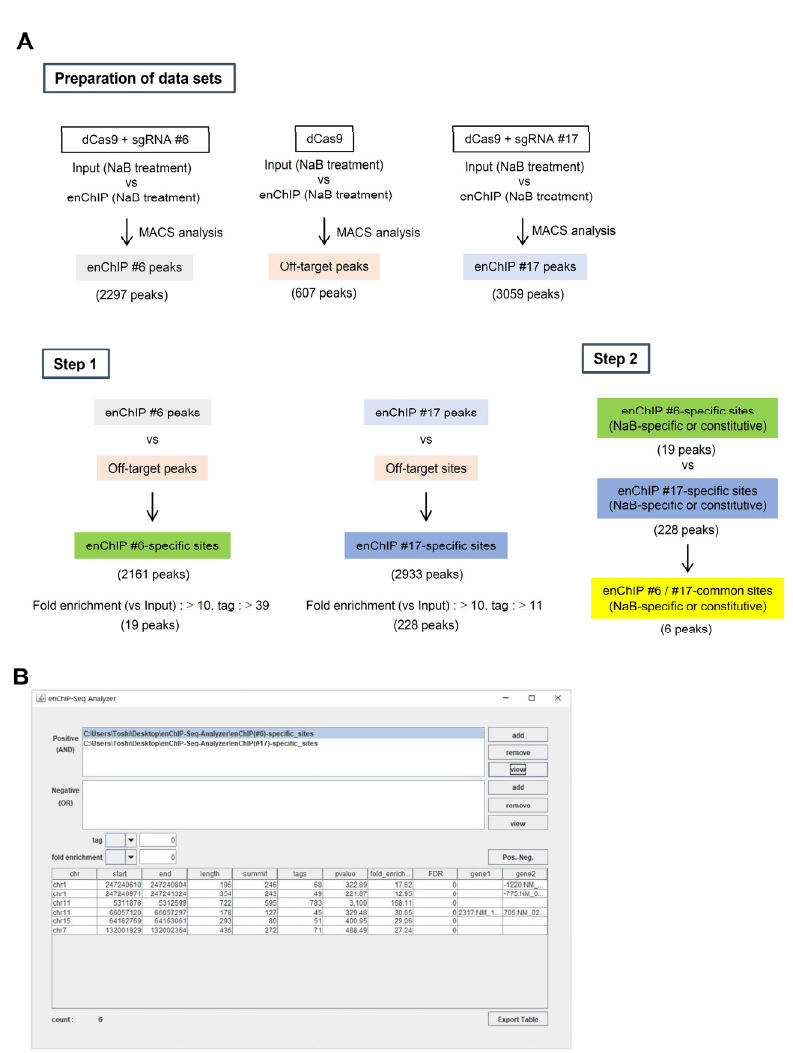
Figure 5. An example of results from enChIP-Seq analyzer. ( A ) Step-by step procedures to extract bona fide genomic regions interacting with a target genomic region. ( B ) An example of the results from enChIP-Seq analyzer.